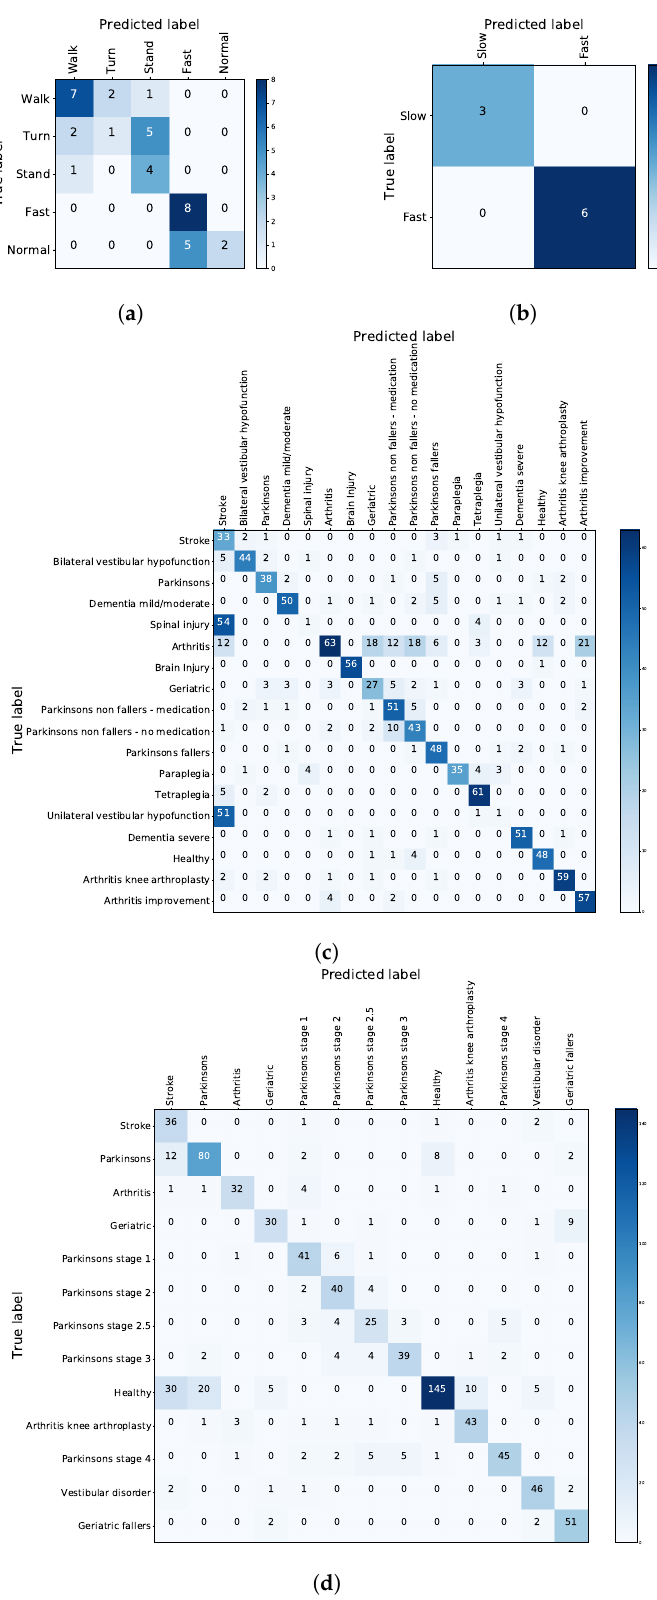
Figure 5. Confusion matrices for the hybrid model presented separately for ( a ) TUG difficulty, ( b ) FTSTS difficulty, ( c ) TUG conditions, and ( d ) FTSTS